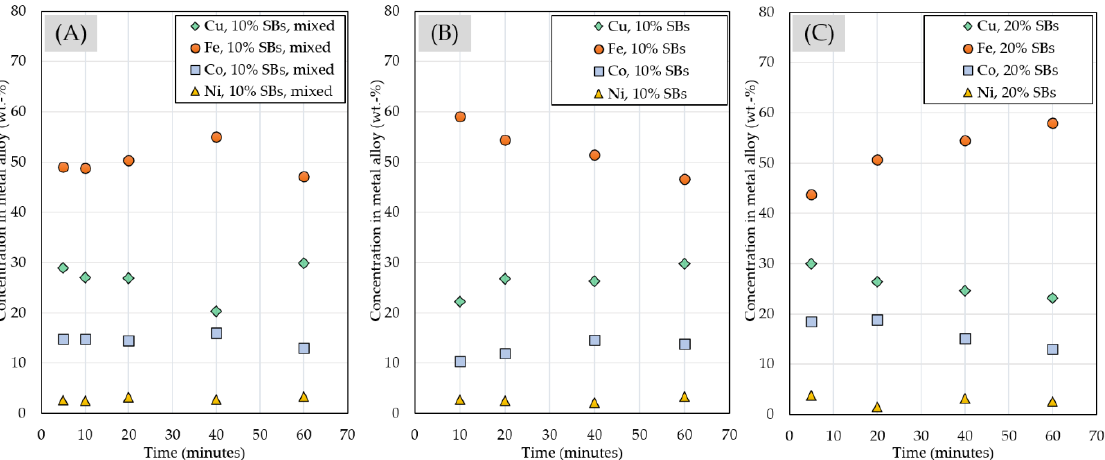
Figure 17. Concentration of Cu, Fe, Co, and Ni in metal alloy in the samples with different starting compositions (( A ) 10 wt.% SBs mixed with slag; ( B ) 10 wt.% SBs on top of the slag; ( C ) 20 wt.% SBs on top of the